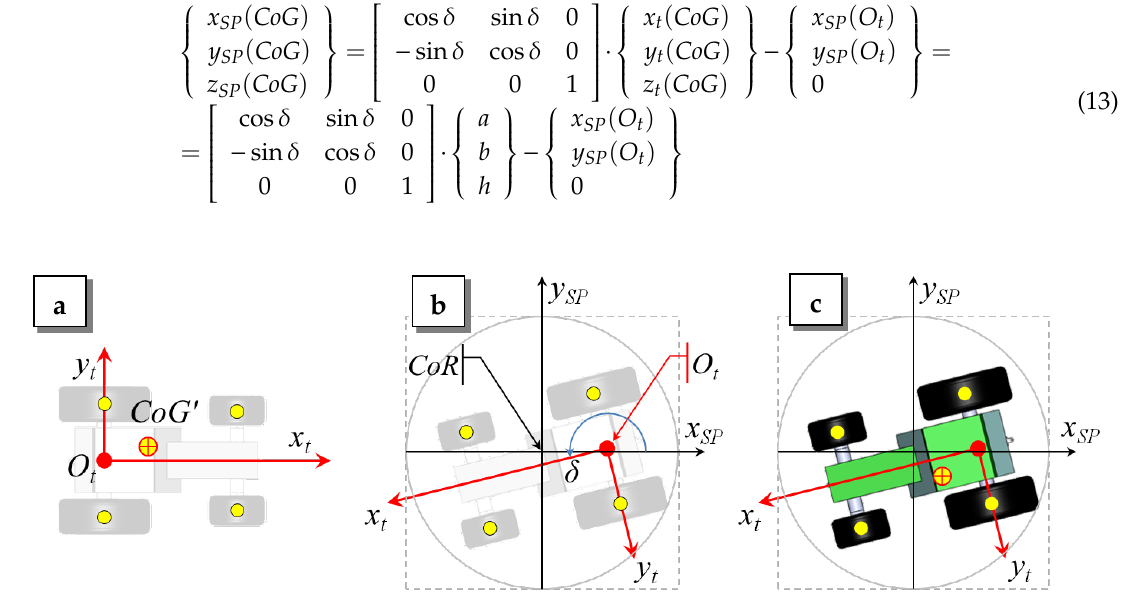
Figure 10. Procedure for positioning the CoG/CoG′ on the support plane frame of reference; ( a ) starting from the CoG/CoG′ position on the vehicle, ( b ) the vehicle reference frame (in red) is placed and ( c ) the coordinates of the CoG are then written in the support plane reference frame.